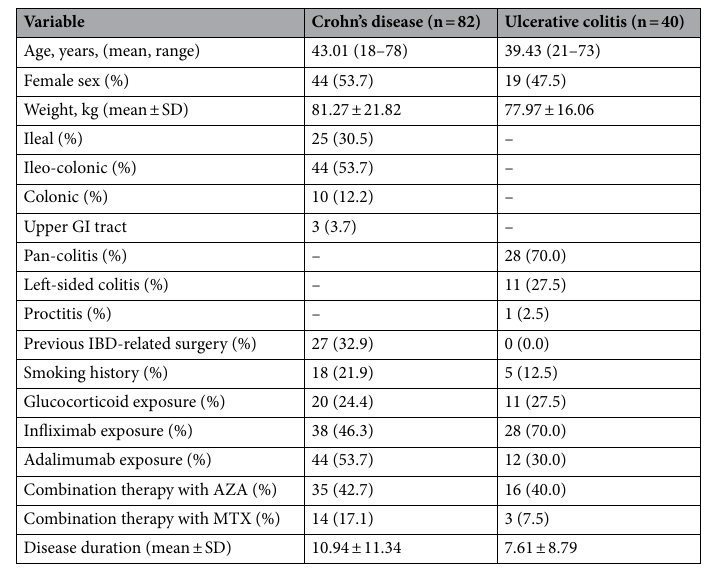
Table 1. Demographic characteristics by disease type. Not significant, ns; kilogram, kg; standard deviation, SD; gastrointestinal, GI; inflammatory bowel disease, IBD; azathioprine, AZA; methotrexate, MTX.